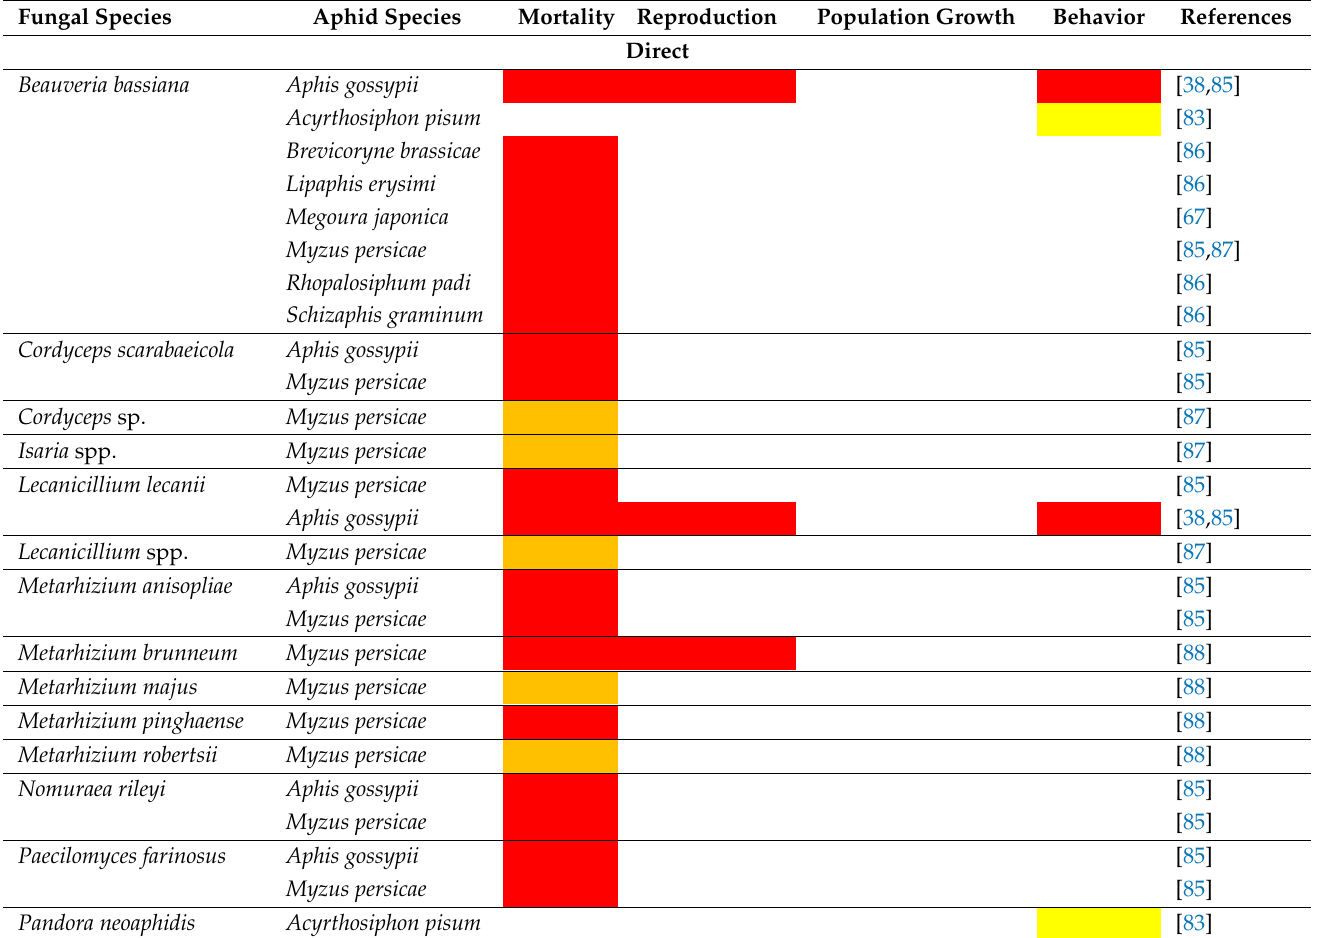
Table 1. Synthetic list of studies on entomopathogenic fungi and target aphid species. Level of impact on the studied parameters (mortality, reproduction, population growth and behavior) is represented by different color codes: red for high; orange for moderate; yellow for low; white for not tested. Fungal Species Aphid Species Mortality Reproduction Population Growth